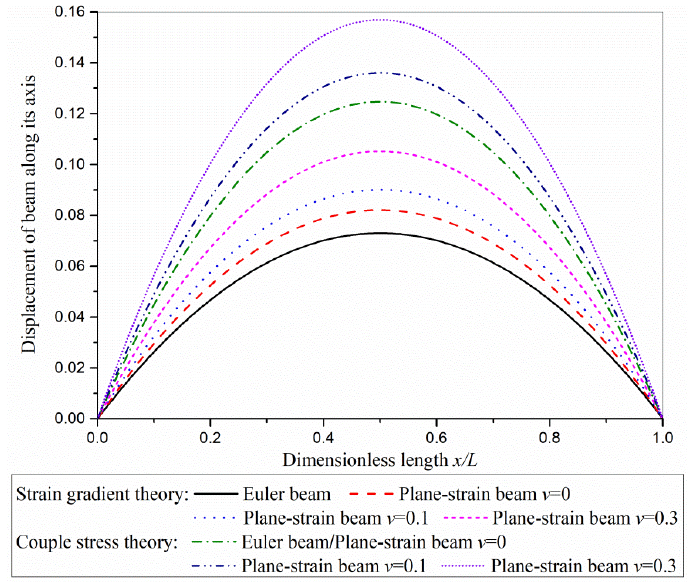
Figure 4. The displacement of beam along its axis.